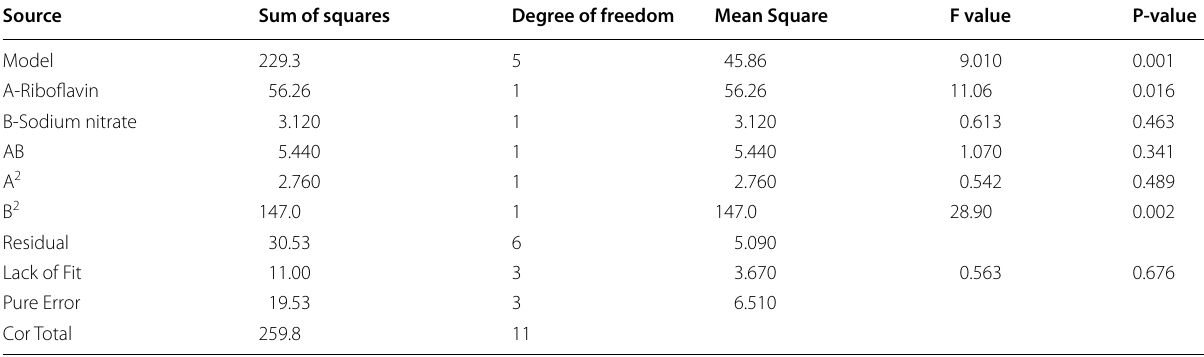
Table 5 Analysis of variance for the response equation developed in the optimization of proteases production by Metarhizium robertsii ARSEF